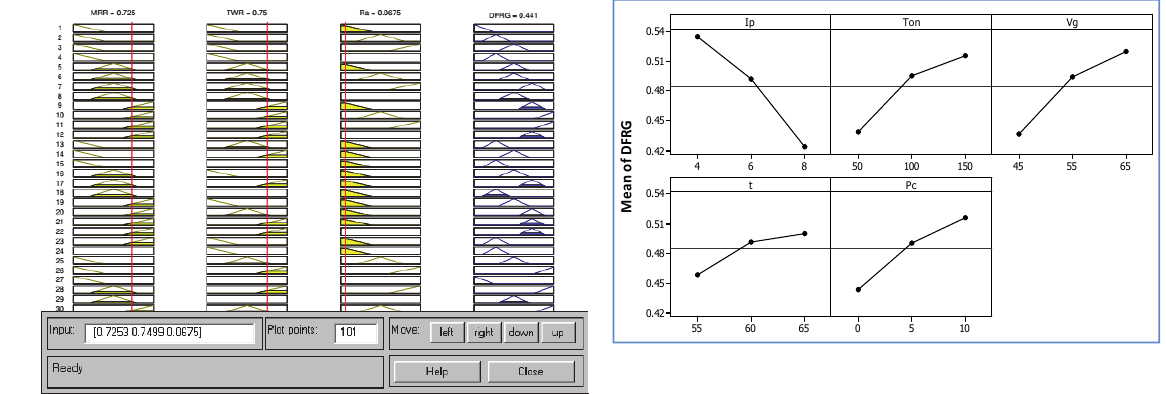
Fig. 3. Fuzzy logic reasoning procedure Fig. 4. Main effect plot for